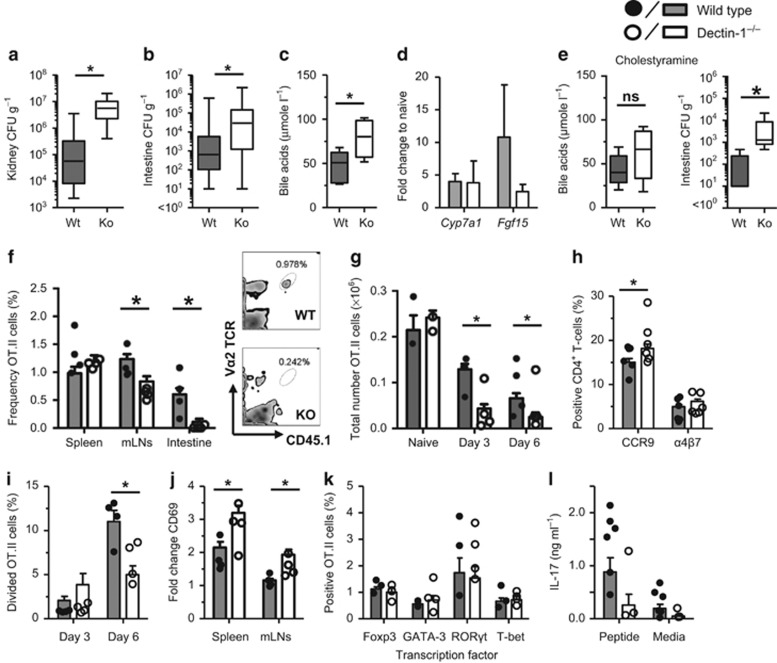
Dectin-1 is required for fungal-specific CD4+ T-cell responses in the GI tract. WT (filled bars/circles) and Dectin-1−/− (clear bars/circles) animals were systemically infected via the tail vein with 2 × 105 CFU C. albicans and analyzed at 72 h post infection for (a) kidney (WT n=25, KO n=25) and (b) small intestine fungal burdens (WT n=17, KO n=21). (c) Bile-acid concentration in the small intestine of infected WT (n=5) and Dectin-1 KO (n=6) mice. (d) The fold change (to naïve controls) in genes regulating bile-acid synthesis (Cyp7a1) or in bile-acid-negative feedback (Fgf15) were measured in 3 day infected livers and intestines (respectively) by quantitative PCR (n=3). (e) WT (n=10) and Dectin-1 KO (n=9) animals maintained on cholestyramine diets starting at 24 h pre-infection until 72 h post infection, when bile acids were measured as in (c), and intestine fungal burdens determined. In other experiments, 3 × 106 OT.II T-cells were transferred into WT and Dectin-1−/− animals, and then infected via the tail vein with 2 × 105 CFU Calb-Ag and analyzed at 72 h post infection. (f) Frequency of OT.II T-cells (CD4+Vα2+CD45.1+) was assessed by flow cytometry in the spleen (n=12), mLNs (n=12), and small intestine (n=8). Example plots are shown for the small intestine and are gated on CD4+ lymphocytes. (g) Total number of OT.II T-cells in the mLN at the indicated time points post infection. (h) Expression of CCR9 (WT n=20, KO n=18) and α4β7 (WT n=16, KO n=14) by CD4+ T-cells in the mLN. (i) The dilution of carboxyfluorescein succinimidyl ester (CFSE) was used to measure proliferation of OT.II cells at day 3 (n=12) and day 6 (WT n=12, KO n=10) post infection in the mLNs. Graph shows percentage of cells that diluted CFSE; see Supplementary Figure S2 for data expressed as the division index.36 (j) Activation of OT.II cells in the spleen (n=8) and mLN (n=12) was determined by staining for CD69 and comparing with naive controls. (k) Expression of indicated transcription factors by OT.II cells in the mLN was analyzed by intracellular staining and flow cytometry at day 3 post infection (WT n=6, KO n=8). (l) 2 × 106 cells from mLN suspensions at day 3 post infection were restimulated in vitro with OVA323-339 peptide and IL-17 in the supernatant measured by ELISA (WT n=10, KO n=6). Bar charts show pooled data (2–4 experiments); overlaid dot plots show a single representative experiment. TCR, T-cell receptor. *P<0.05.